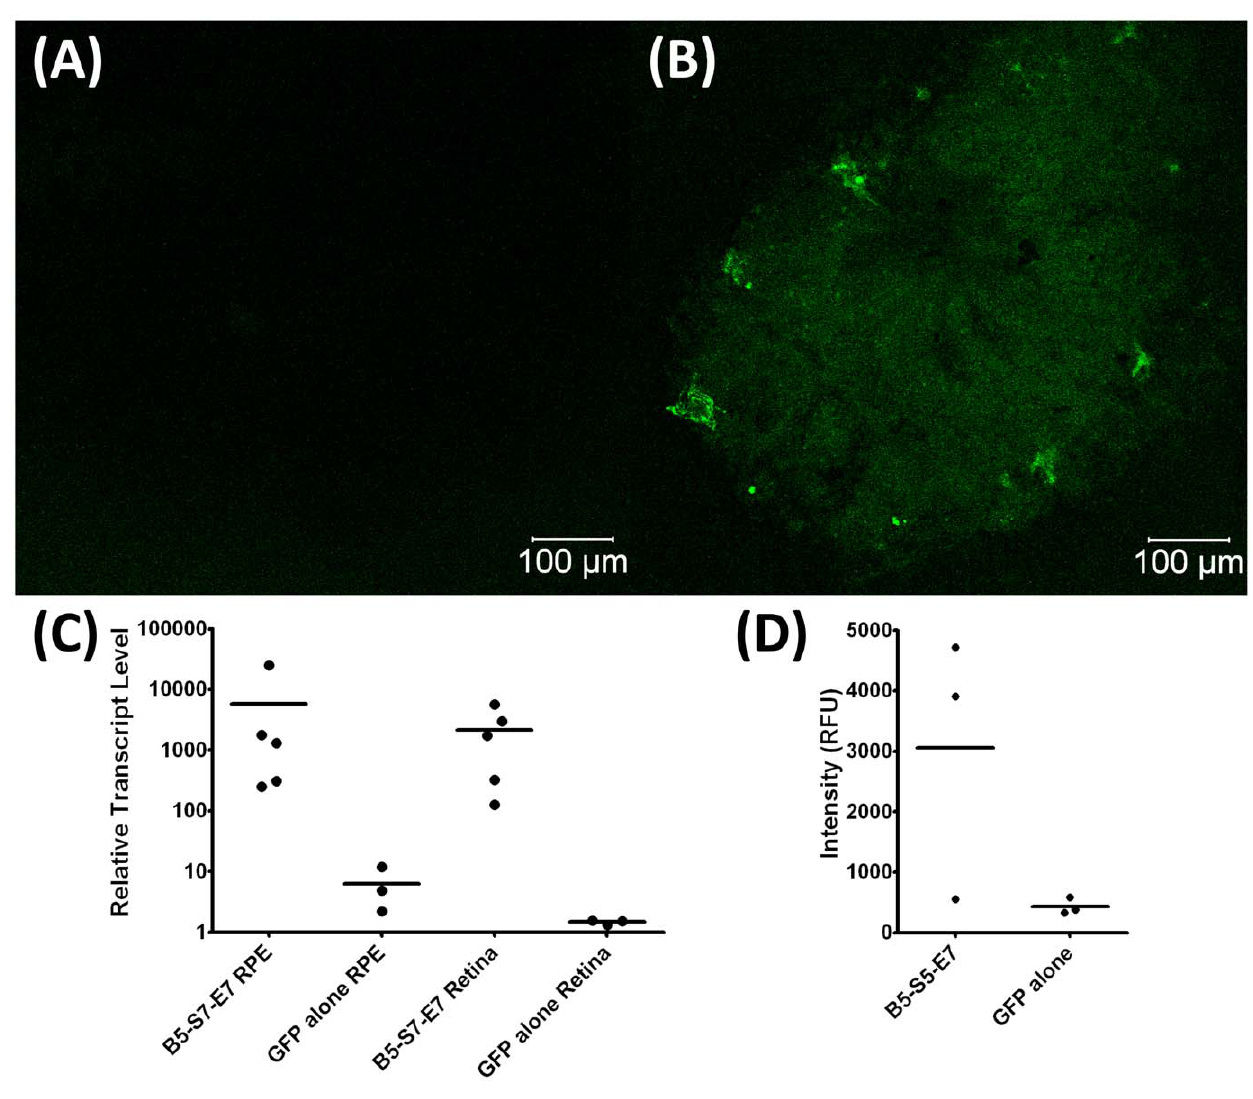
Figure 10. Confocal image of RPE/choroid flat mount post subretinal injections; green corresponds to fluorescence due to GFP expression. Both images were taken with the same camera settings. (A) pDNA alone. (B) pDNA/nanoparticle injection. (C) Relative transcript level to GAPDH (set at 10,000) of GFP mRNA expression after subretinal injection of PBAE eGFP nanoparticles and subretinal injection of naked DNA. Each injection is diplayed as a separate point, and the mean relative transcript level is displayed as a bar. Subretinal injections using lyophilized GFP-PBAE nanoparticles resulted in 1.1 6 1 6 10 3 -fold and 1.5 6 0.7 6 10 3 -fold increased GFP expression in the RPE/choroid and neural retina, respectively, compared to injection of DNA alone (p=0.003 for RPE/choroid, p , 0.001 for neural retina). (D) Relative fluorescence intensity of retinal flat mounts after subretinal injection with GFP nanoparticles and GFP plasmid alone (n=3).